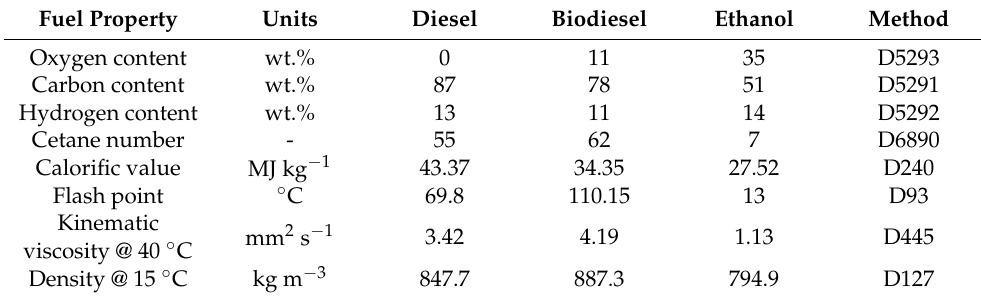
Table 1. Properties of diesel, biodiesel, and